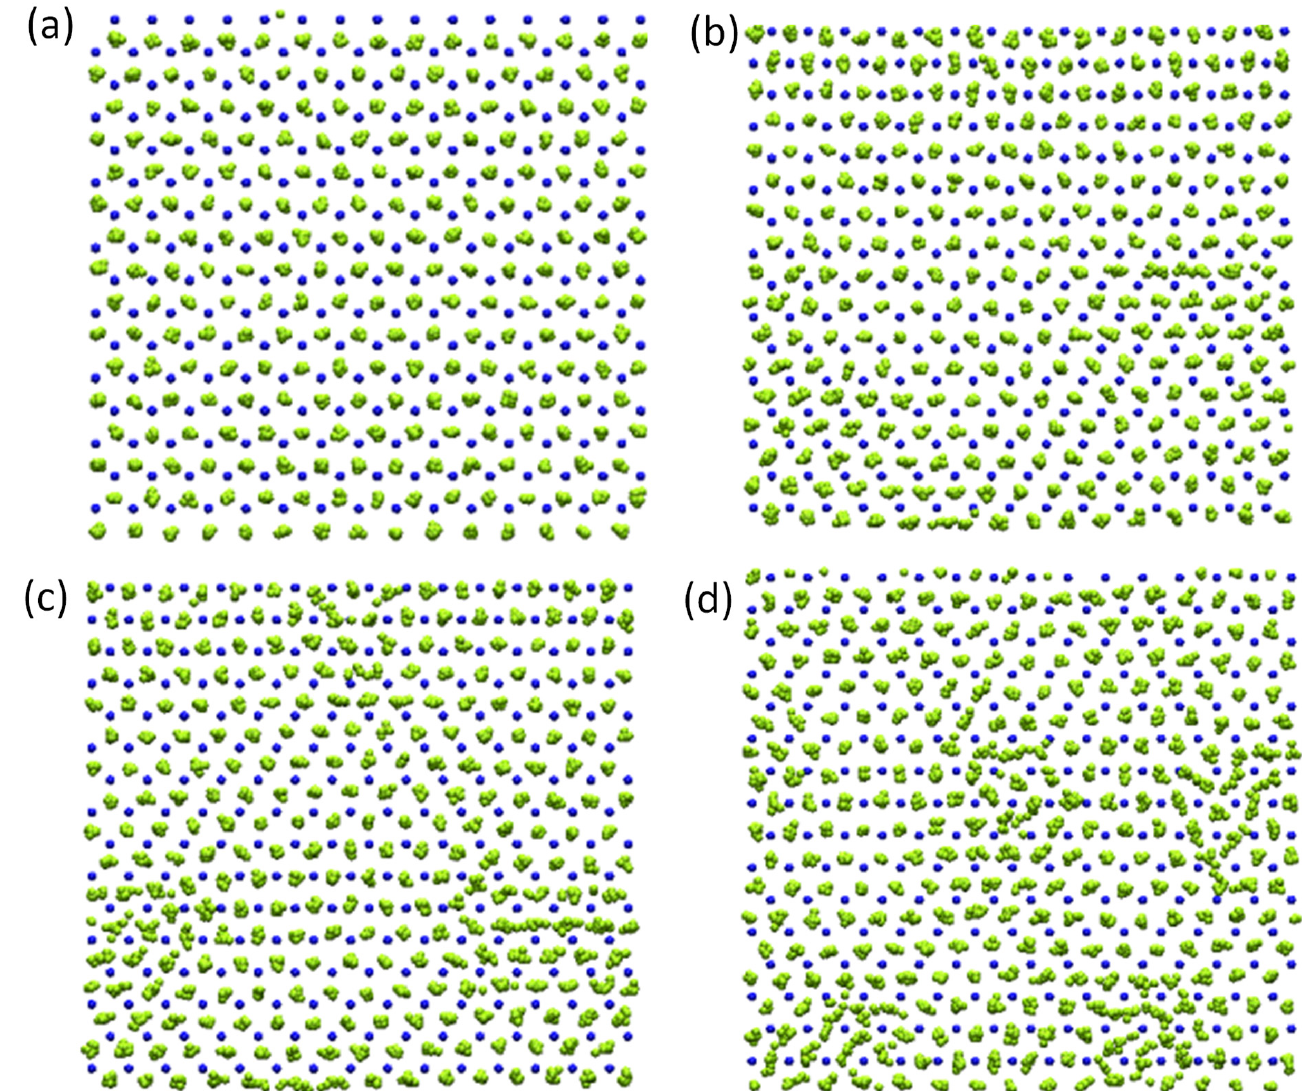
Figure 5. Prenucleation in systems with negative lattice misfits demonstrated by atomic ordering in L1 templated by the substrate [18]. Time-averaged atomic positions in L1 relative to the surface layer (L0) of the substrate, averaged over a period of 10 ps, are displayed for the systems with ( a ) f = 0%, ( b ) − 2%, ( c ) − 4%, and ( d ) − 8% equilibrated at 900 K. The blue and green spheres represent the atoms in the surface layer of the substrate and the first layer of the liquid (L1), respectively. For f = 0%, L1 exhibits an almost fully ordered structure, which consists of the solid-like atoms. With increasing